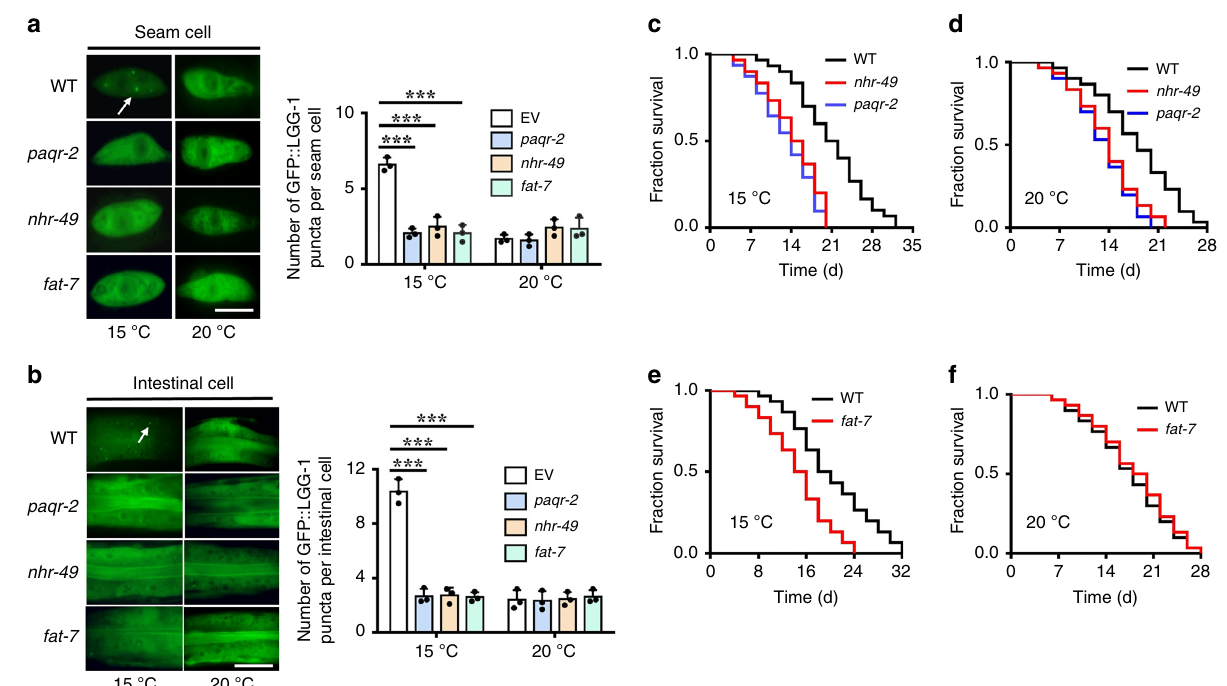
Fig. 3 The PAQR-2 signaling acts upstream of autophagy to extend lifespan. a , b Representative images of autophagosomes (GFP::LGG-1 puncta) in the seam cells ( a ) and intestinal cells ( b ) of paqr-2(tm3410) , nhr-49(nr2041) , and fat-7(wa36) mutants at 15 °C and 20 °C, respectively. The arrow denotes a representative autophagosome. The numbers of GFP::LGG-1 puncta were counted in the seam cells and intestinal cells. These results are means ± SD of three independent experiments ( n = 30 – 35 worms per experiment). *** P < 0.001, wild type (WT) versus mutants at 15 °C, one-way ANOVA followed by a Student-Newman-Keuls test. Scale bars: seam cells, 10 μ m; intestinal cells, 20 μ m. c , d Mutations in paqr-2(tm3410) and nhr-49(nr2041) shortened lifespan of worms at 15 °C ( c ) and 20 °C ( d ). P < 0.001, WT versus mutants at 15 °C and 20 °C, respectively. See Supplementary Data 1 for details. e , f fat-7(wa36) mutant worms exhibited a short lifespan at 15 °C ( e ) ( P < 0.001, WT versus mutants), but not at 20 °C ( f ). See Supplementary Data 1 for details. P